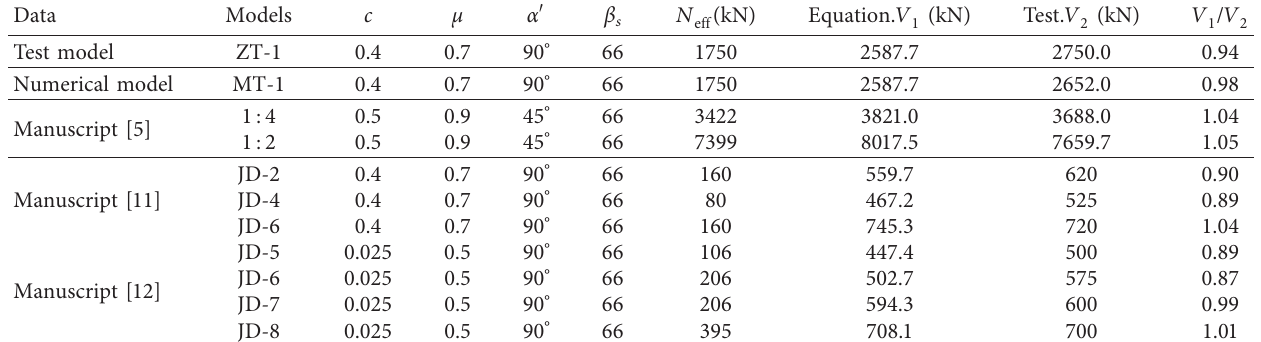
Table 7: Comparison of theoretical and experimental